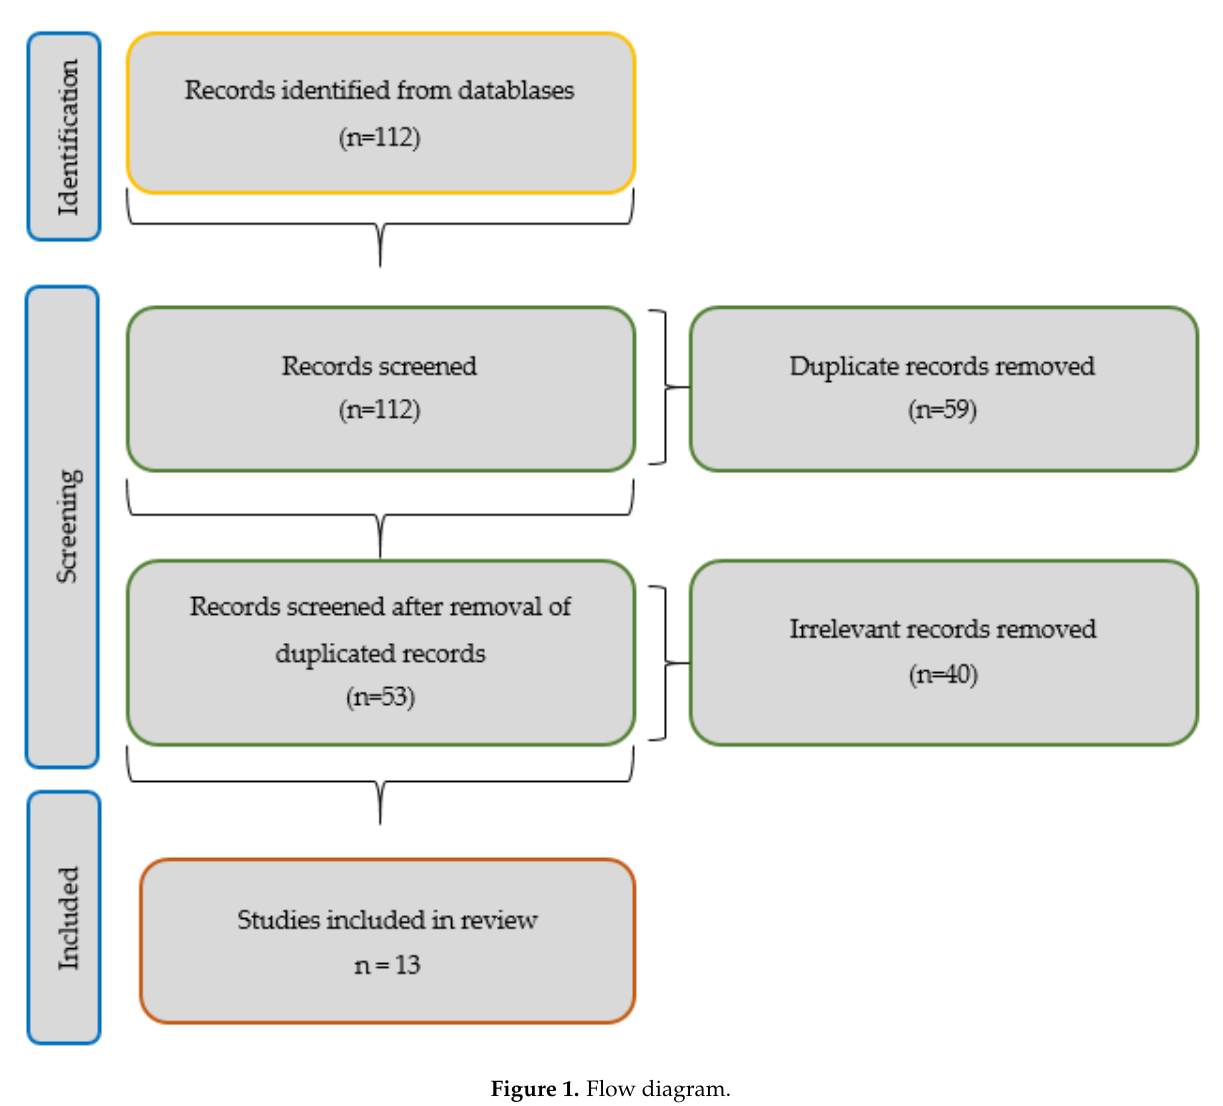
Figure 1. Flow diagram. Table 2. Databases